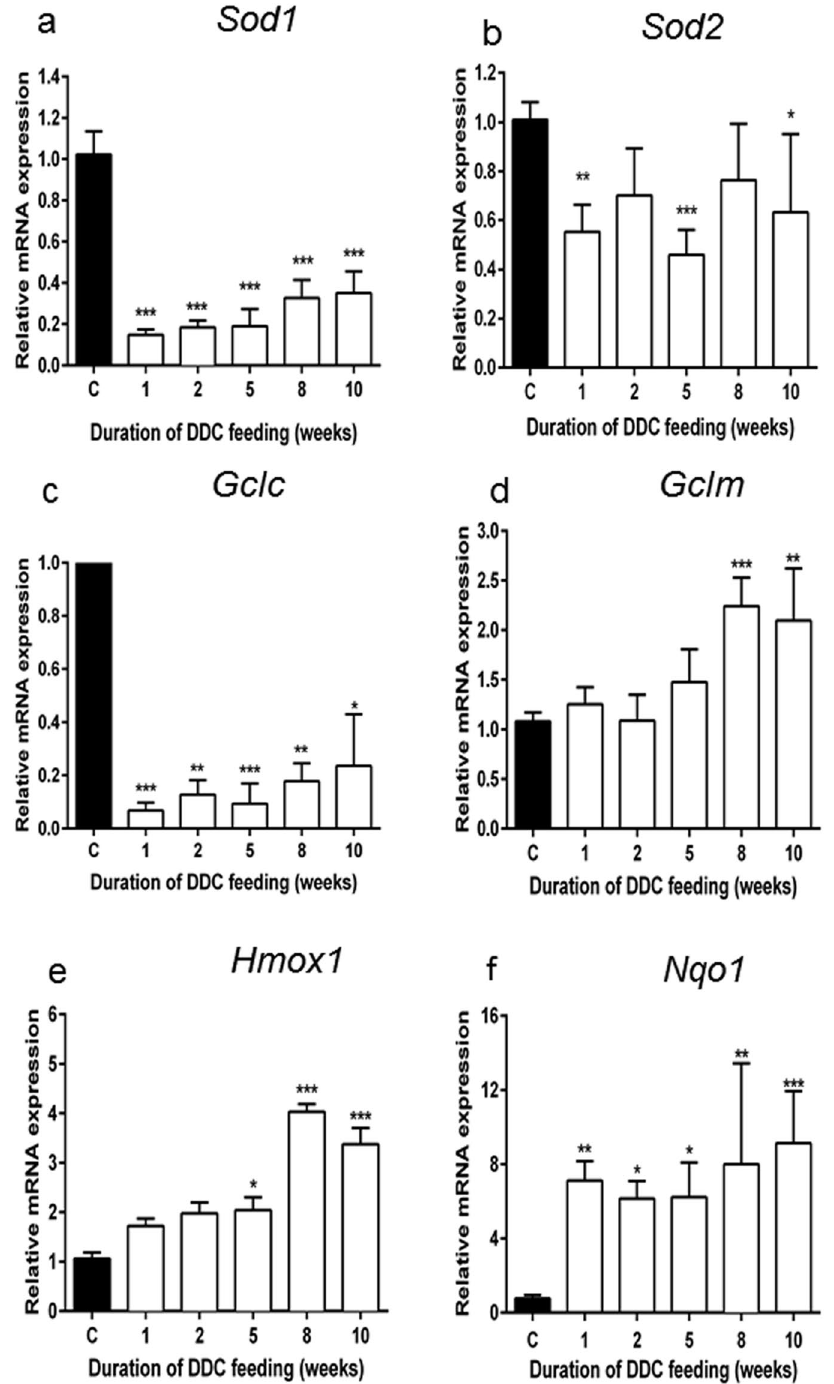
Figure 2. Effect of DDC on the expression of antioxidant and stress-response genes. Normalized expression levels of ( a ) superoxide dismutase 1 ( Sod1) , ( b ) superoxide dismutase 2 ( Sod2) , ( c ) glutamate-cysteine ligase, catalytic subunit ( Gclc) , ( d ) glutamate-cysteine ligase, modifier subunit ( Gclm) , ( e ) heme oxygenase 1 ( Hmox1) , and ( f ) NAD(P)H dehydrogenase quinone 1 ( Nqo1) were evaluated by qRT-PCR of mRNA extracted from whole liver tissue. Data are represented as mean ± SD collected from 5 animals per treatment group and shown as fold-change relative to controls. Significances of DDC intoxication stages are shown versus controls: * p < 0.05; ** p < 0.01; *** p <